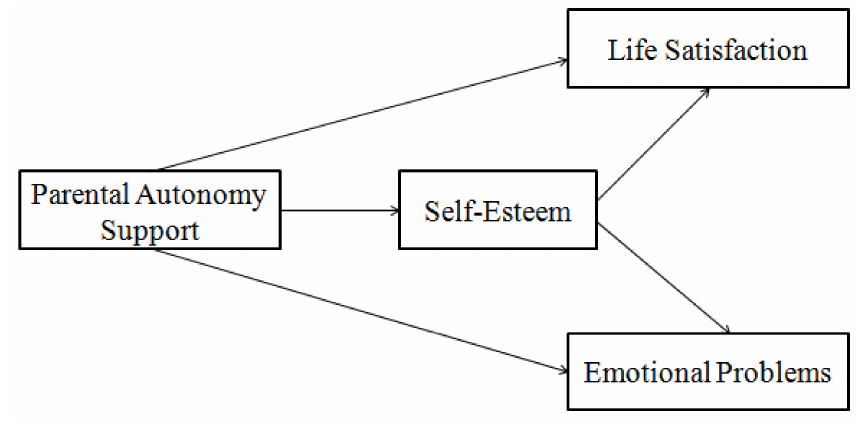
Figure 1. Hypothesized